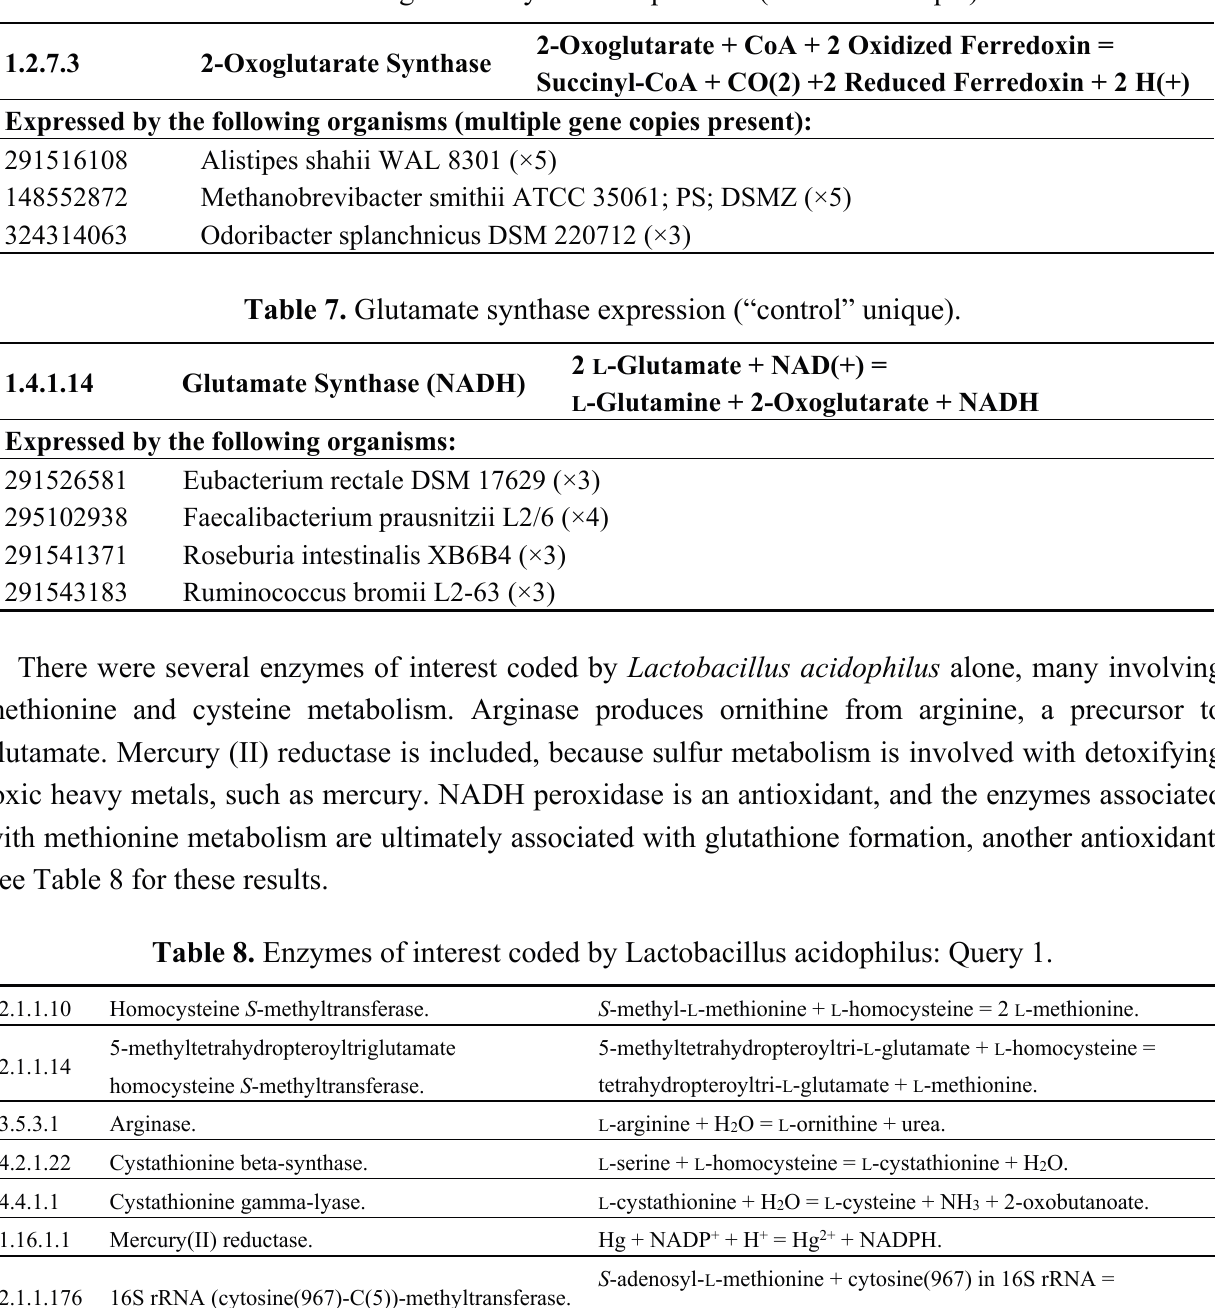
Table 6. 2-oxoglutarate synthase expression (“control” unique).